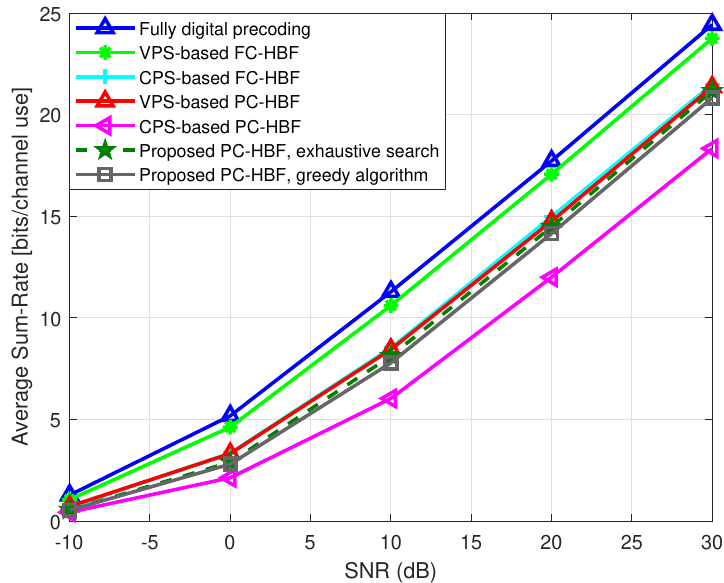
Figure 2. Average sum rate versus SNR. N t = 12 and U =